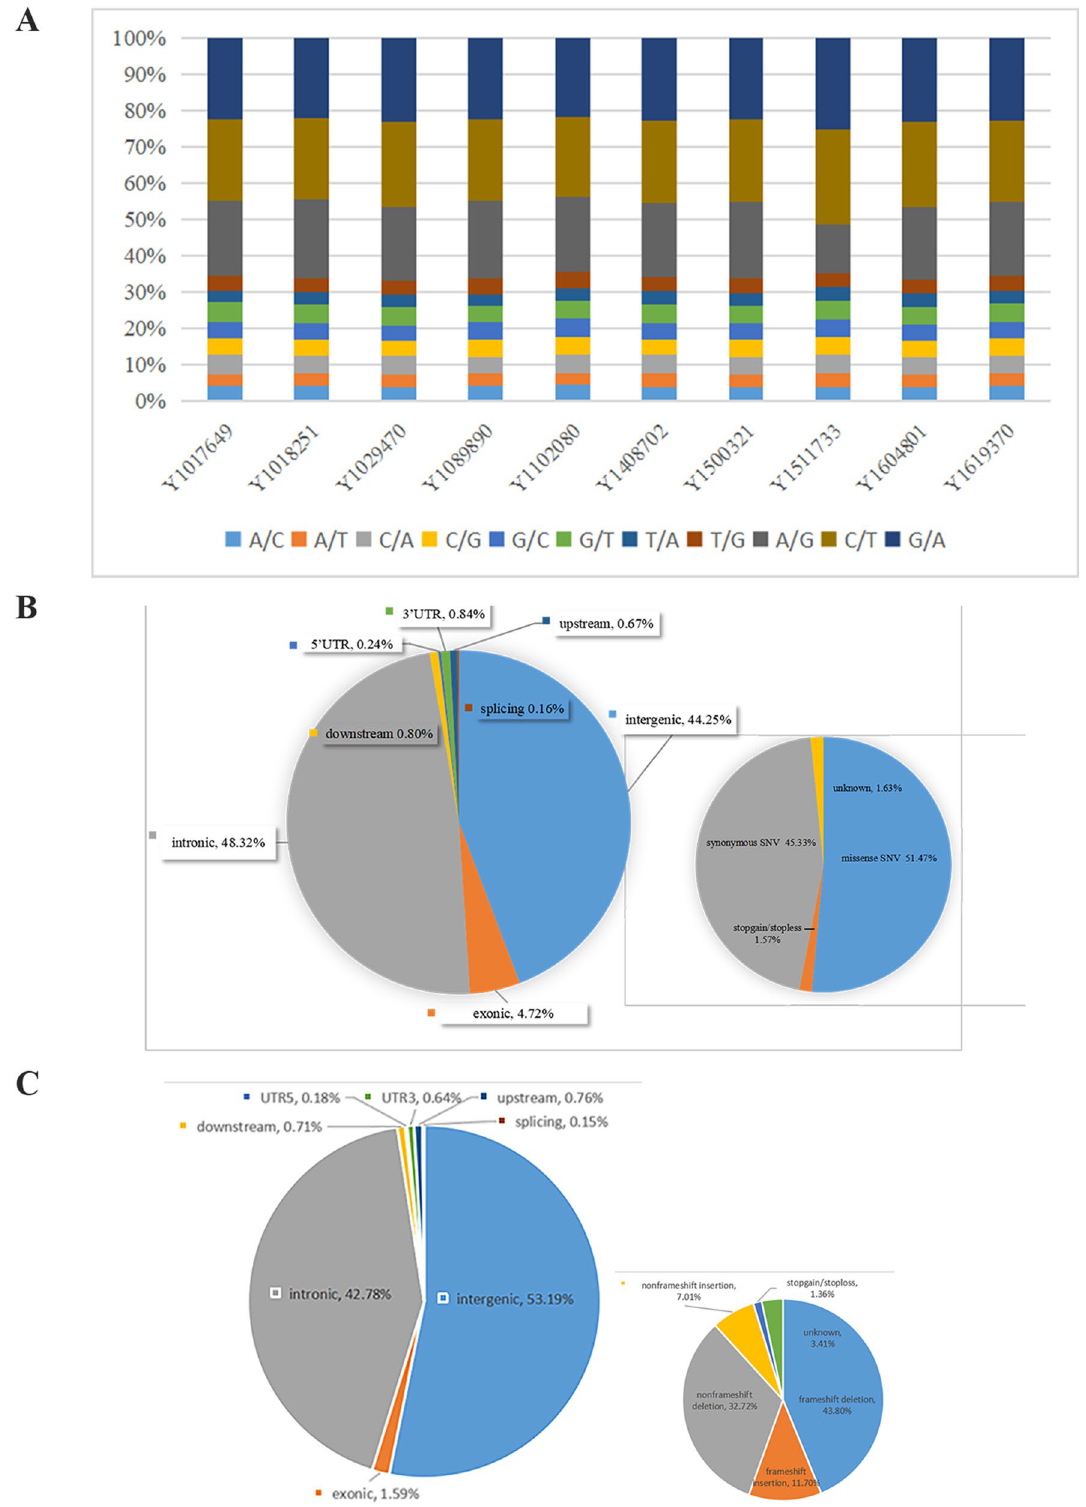
Figure 1. Targeted sequencing of 10 patients with hypopharyngeal cancer ( A ). The proportion of nucleotide mutations in 10 patients with hypopharyngeal cancer ( B ). The proportion of mutation in different regions in SNV and the proportion of different mutation type in exon regions ( C ). The proportion of mutation in different regions in indel and the proportion of different mutation type in exon